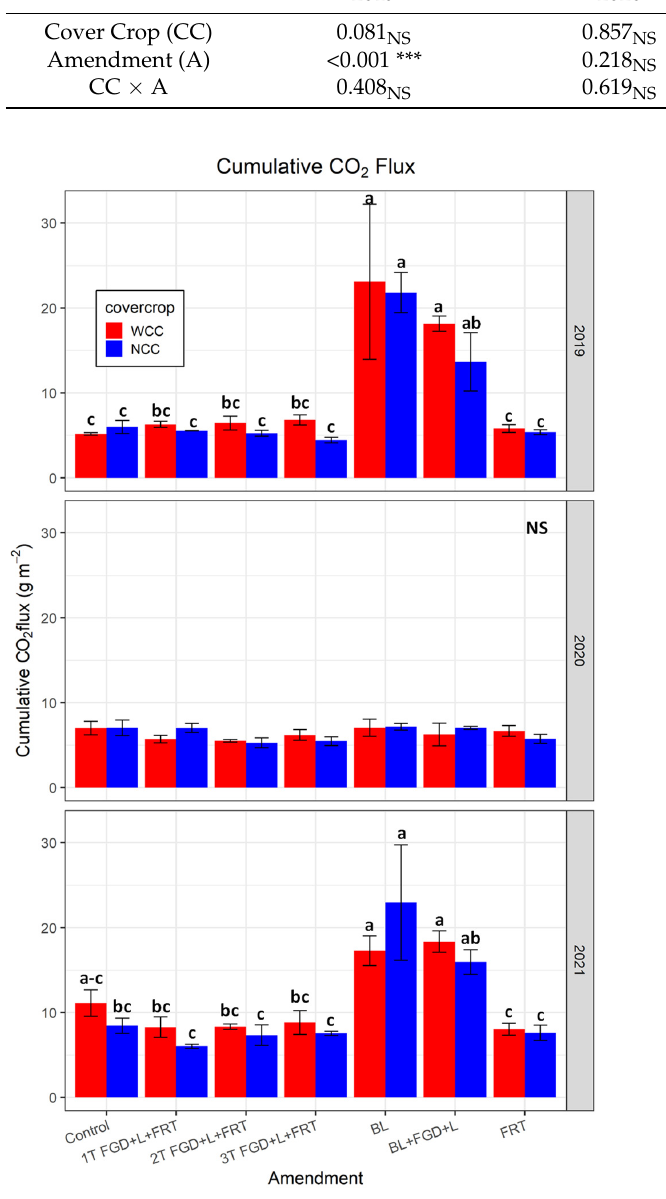
Figure 6. Cumulative CO 2 flux. Red and blue bars represent the mean of replicates, and error bars are standard errors (n = 3). Lower case letters with no common letters denoting significant differences of Tukey’s multiple comparison tests at α = 0.05 (NS: no significant difference). WCC: with cover crop; NCC: no cover crop. Table 5. Effects of cover crop, amendment and their interactions on cumulative CO 2 flux. The num- bers presented in the table are p values from the ANOVA test. *— p < 0.05, **— p < 0.01, ***— p < 0.001, and NS—not significant.